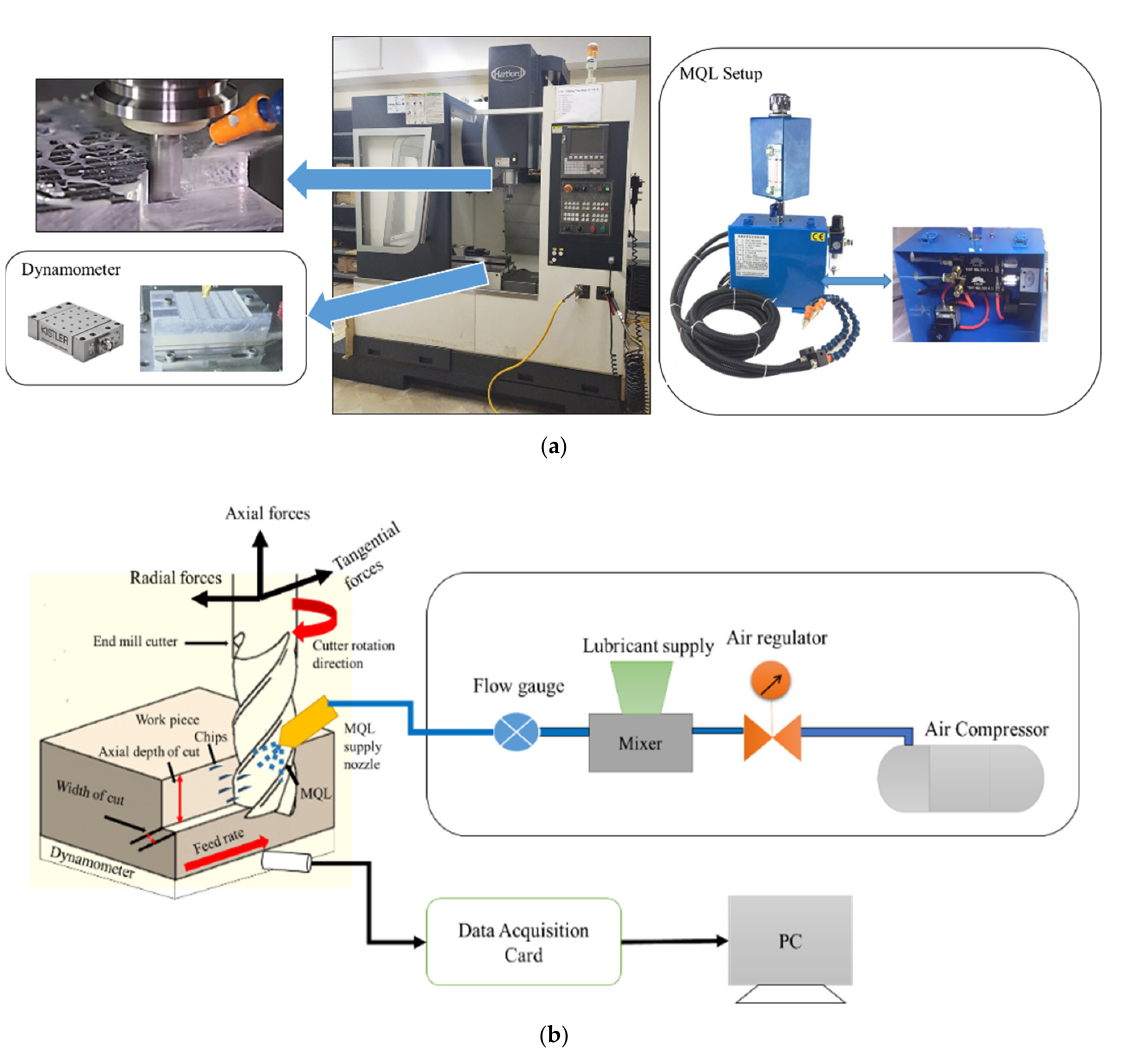
Figure 1. Experimental setup of end-milling machining under minimum-quantity lubrication (MQL). ( a ) Actual experimental setup, ( b ) schematic of the experimental setup. A blend of vegetable oil, namely olive and canola oil (Meezan Group, Karachi Paki ‐ stan), was used as a lubricant because of its biodegradability and good lubricating prop ‐ erties having a relative density of 0.910–0.920 g/cm 3 at 20 °C, the kinematic viscosity of 79 mm 2 /s at 20 °C, and specific heat of 1.905–1.978 J/g at 20 °C and boiling point 250 °C. They are supplied at 5 ‐ bar using a single nozzle inclined at 45°. Experimental runs were de ‐ signed based on a definitive screening design (DSD). Cutting process parameters and their levels were selected based on literature review, initial experimental runs, and according to a recommendation made by the tool manufacturer. The selected machining parameters, cutting conditions, and their levels are shown in Table 2. Table 2. Cutting parameters/conditions and their levels.